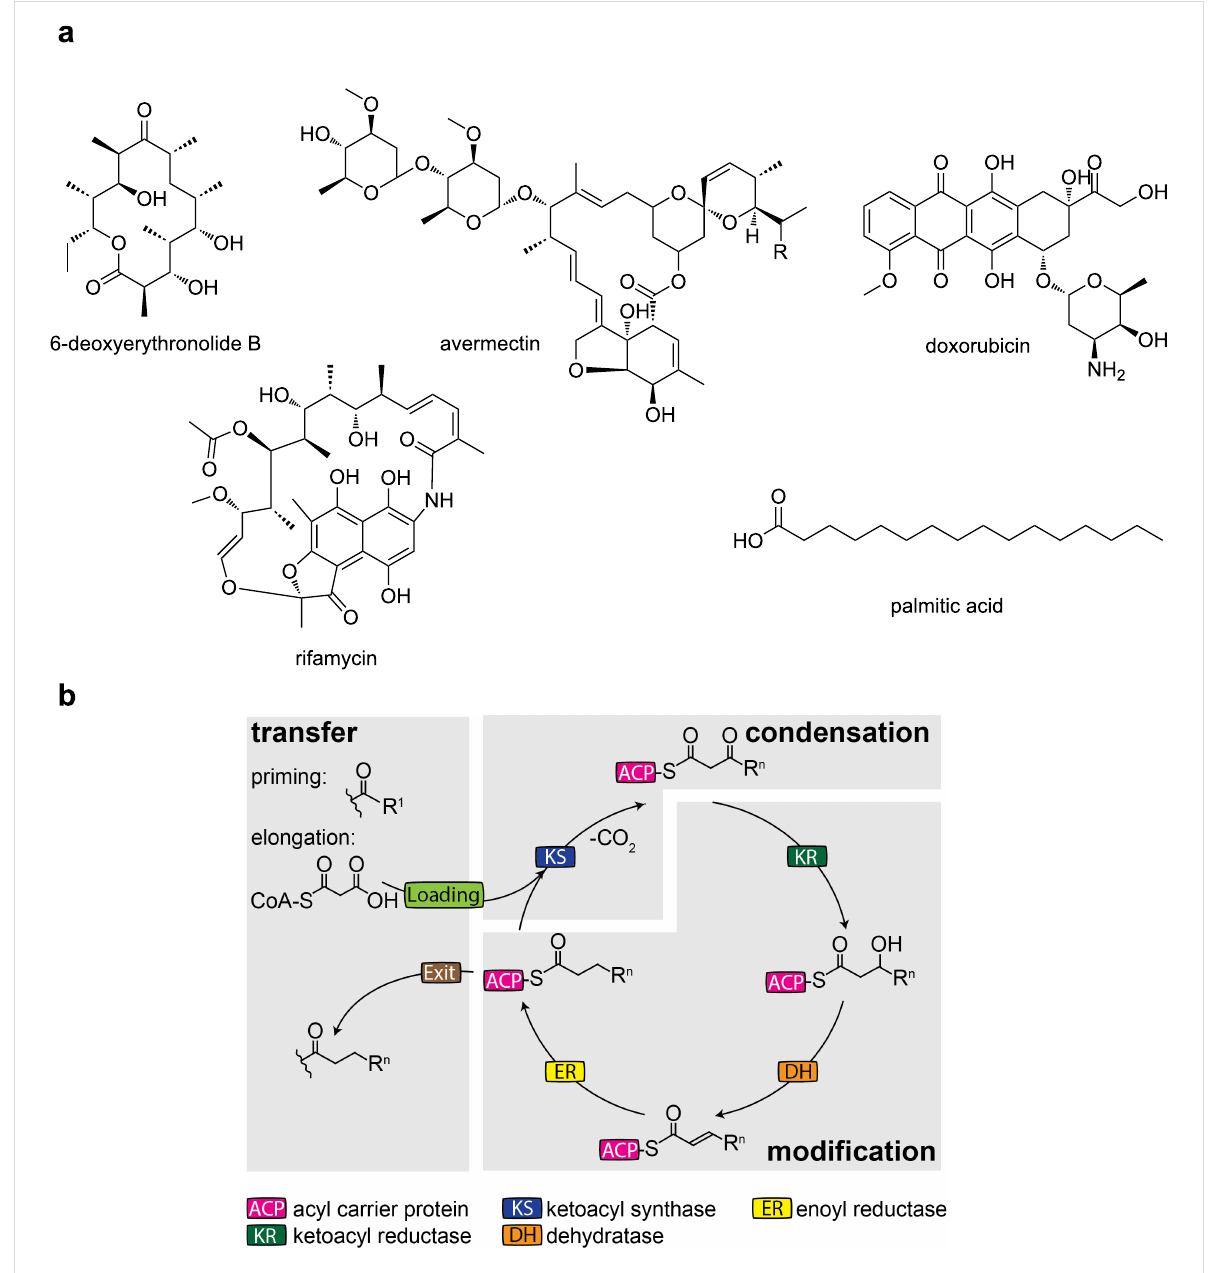
Figure 1: Megasynthases – chemistry and modes of action. a) Products of PKS and FAS megasynthases. b) Reaction cycle of iterative fatty acid bio- synthesis as performed by fatty acid synthases (FAS). Synthesis by PKS is essentially similar, except a variation in the degree of β -carbon modifica- tion, and the variation in loading and exit transferases. Modular PKS perform one cycle per module before translocating the substrate to the next module.